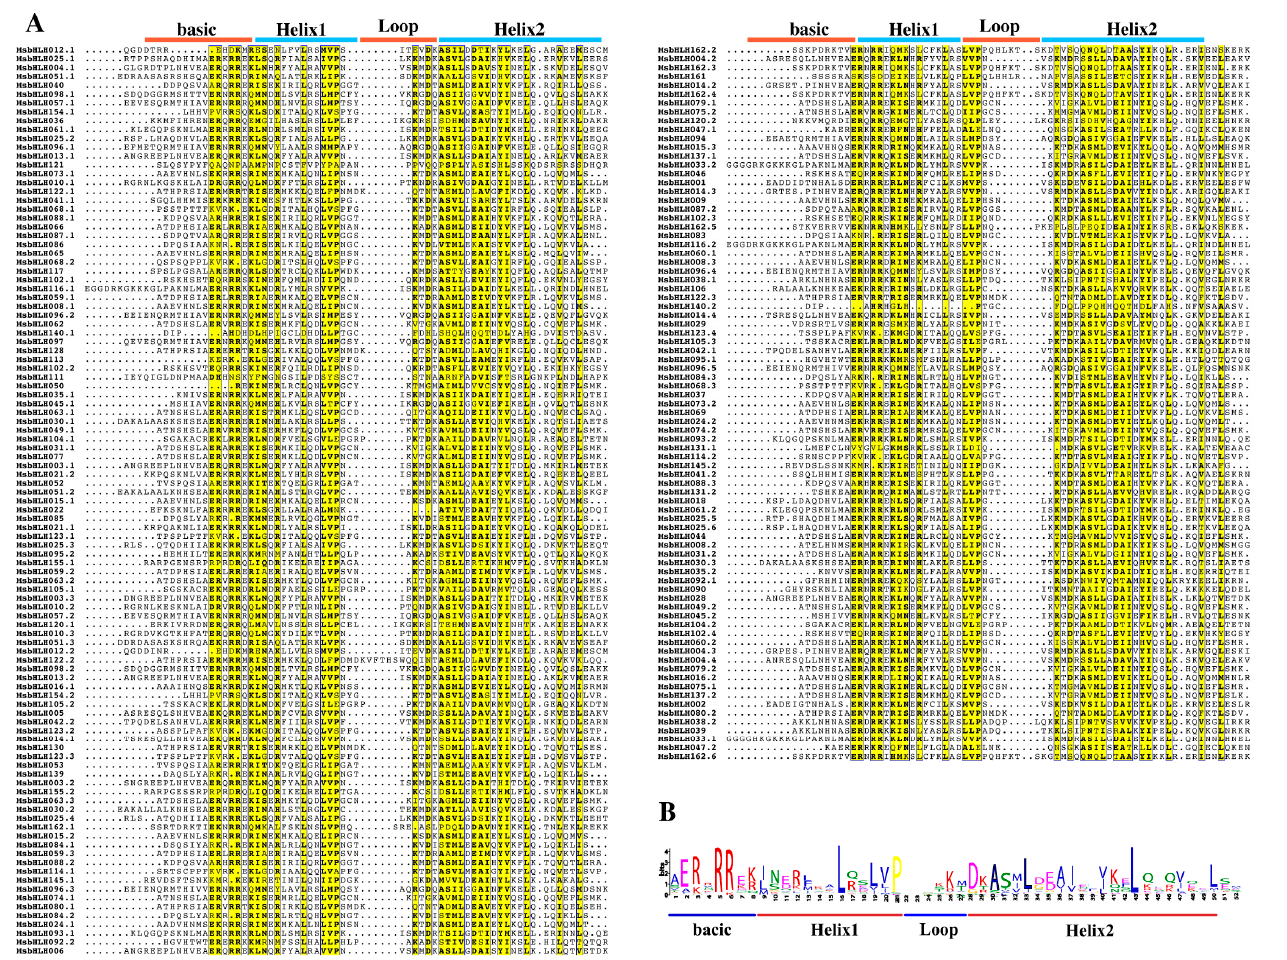
Figure 1. Conserved domains in putative MsbHLH proteins. ( A ) Amino acid sequence alignment analysis of MsbHLH protein. ClustalW and ESPript 3.0 were used to create a multi-sequence alignment project with default parameters of the MsbHLH proteins. The similarity coloring scheme shows % equivalence; global score was 0.7. ( B ) Conservative motif of MsbHLH transcription factor. The MEME online program was used to analyze the motifs of the MsbHLH proteins, the number of motifs was 10, the optimum motif width was from 8 to 60, and other settings were defaults.